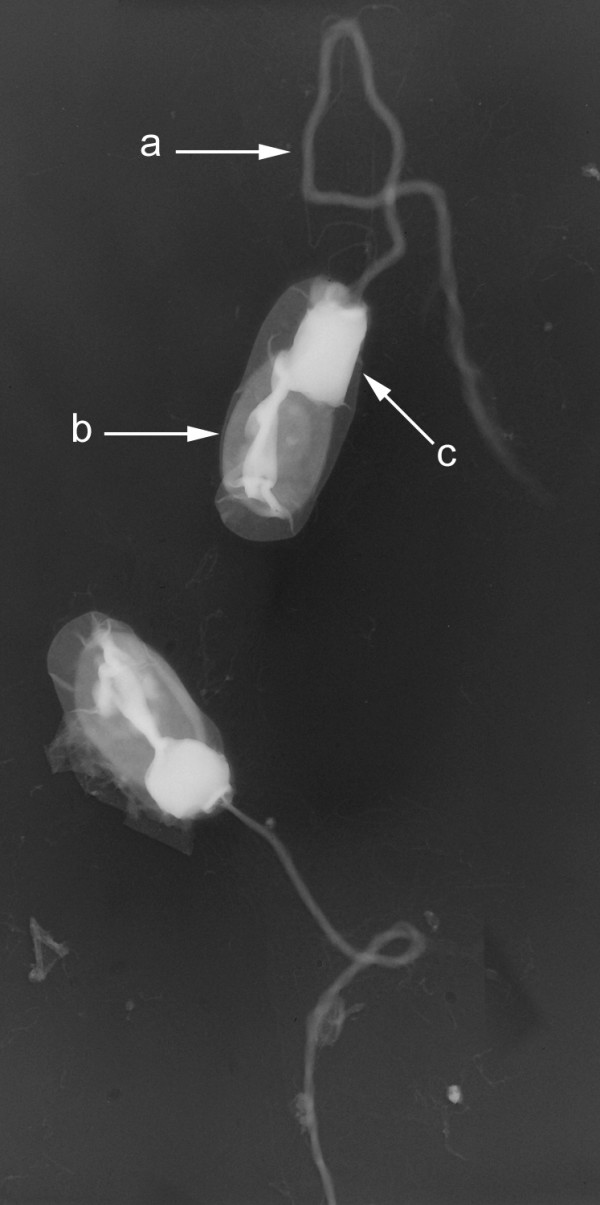
Electron Micrograph of Bt2-56. A Transmission Electron Micrograph of negatively stained spores from Bt2-56 containing a filament (a), and a sac-like structure containing a spore (b) and parasporal body (c).